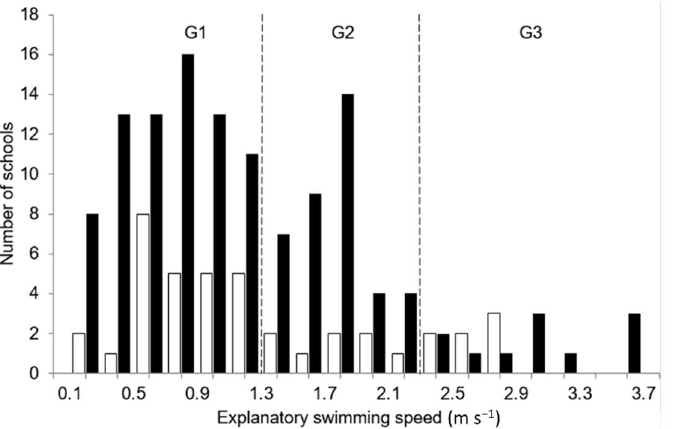
Figure 5. Histogram of average Exploratory Swimming Speed of fish schools observed in the Prevost (black) and Ingril (white) lagoons. Three groups (G1; G2 and G3) might be distinguished at a similar swimming speed interval (~1.25 m s − 1 ), which were assumed to be related to main migratory gregarious species: mugilidae juveniles (G1: Fork length ‘FL’ < 7.5 cm), juveniles of Sparus aurata and Dicentrarchus labrax (G2: FL ~ 13 cm), and G3 composed of sub-adults of several species (mullets, S. aurata and D. labrax ) with an average FL size around 20 cm.